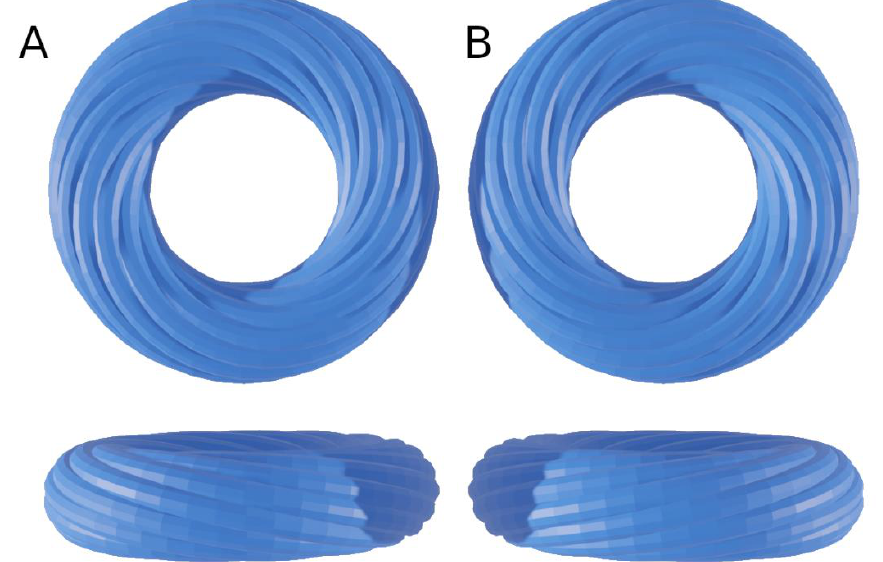
Figure 5. Graphical examples of tori covered with geodesics. Geodesics are pictured as close spaghetti wrapped around the torus; they wrap around the small circumference each time they wrap around the large circumference. A regular curve is right-handed when the current point moves away from the centre; the radius vector rotates counter-clockwise [28]. Column ( A ) Right-handed torus covered by geodesics. Column ( B ) Left-handed torus covered by geodesics. Top row: superior or inferior view (both are identical). Bottom row: lateral view.